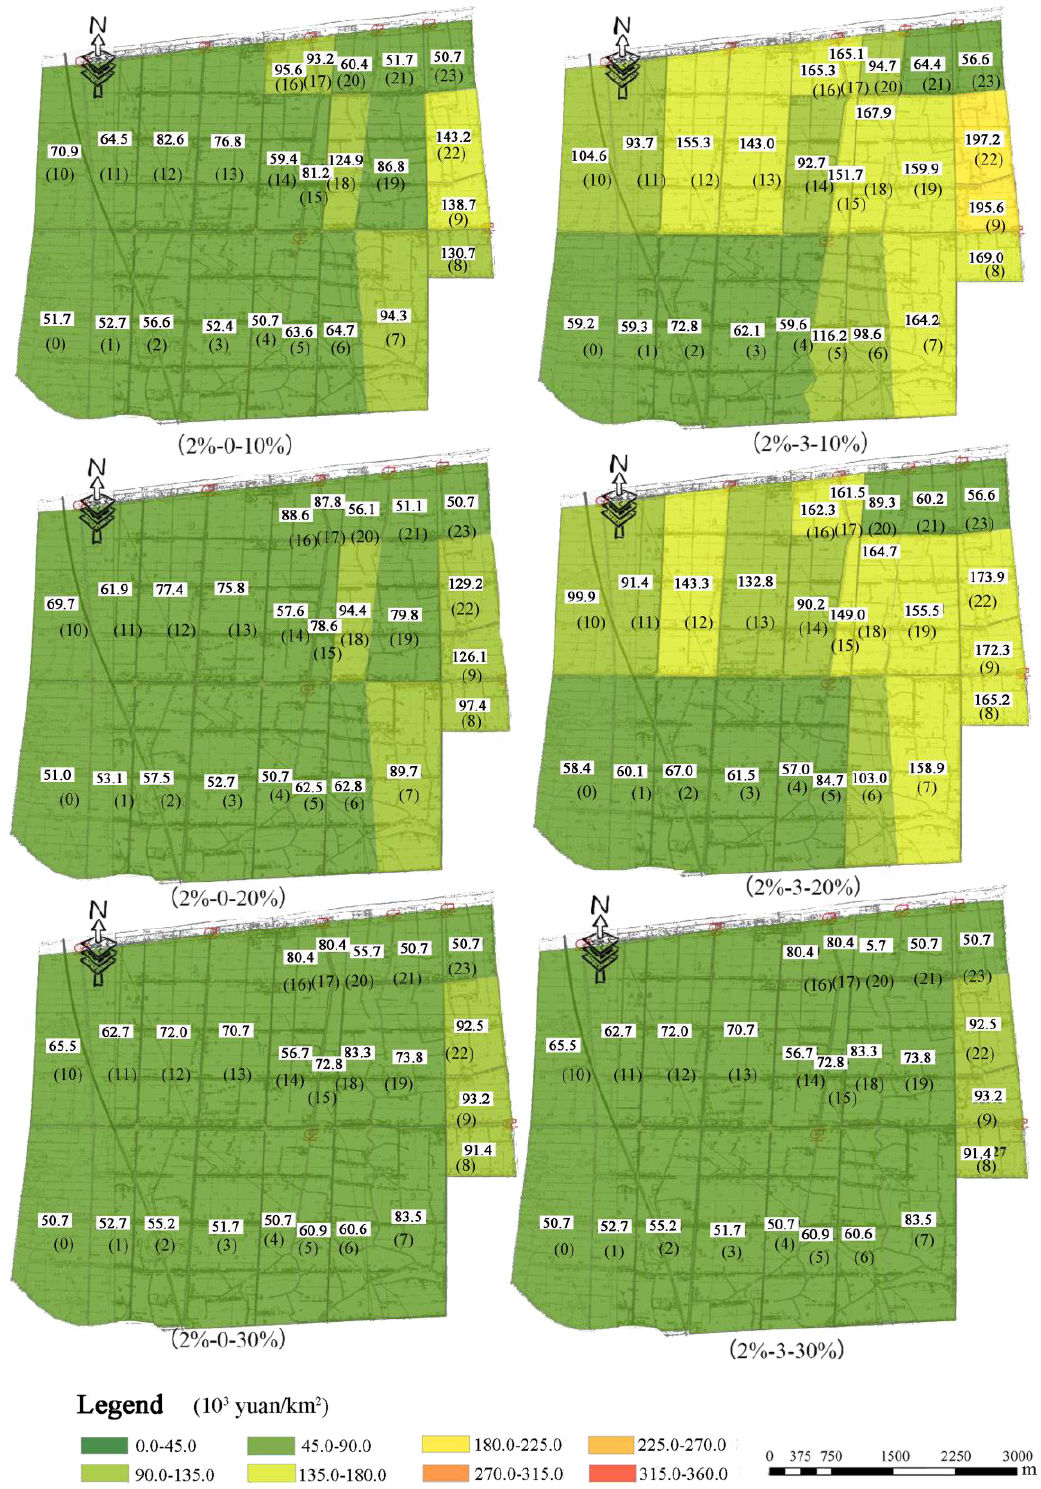
Figure 13. Distribution of averaged waterlogging loss with different initial storage depths and work scales under 2% frequency.